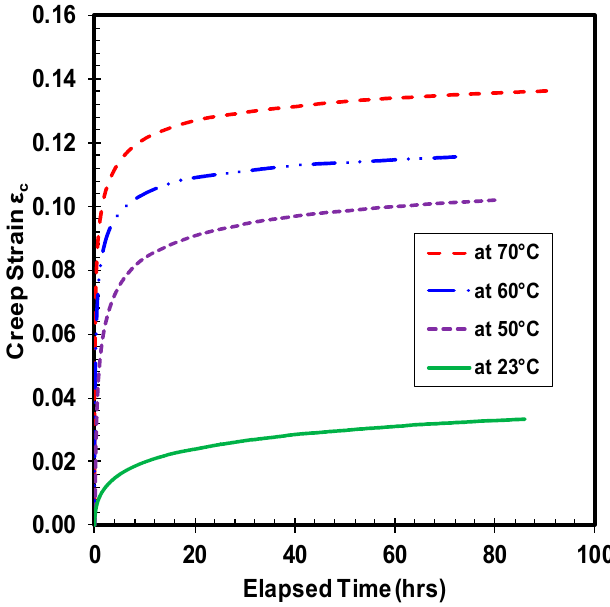
Figure 4. Creep strain under different temperatures at 14 MPa.